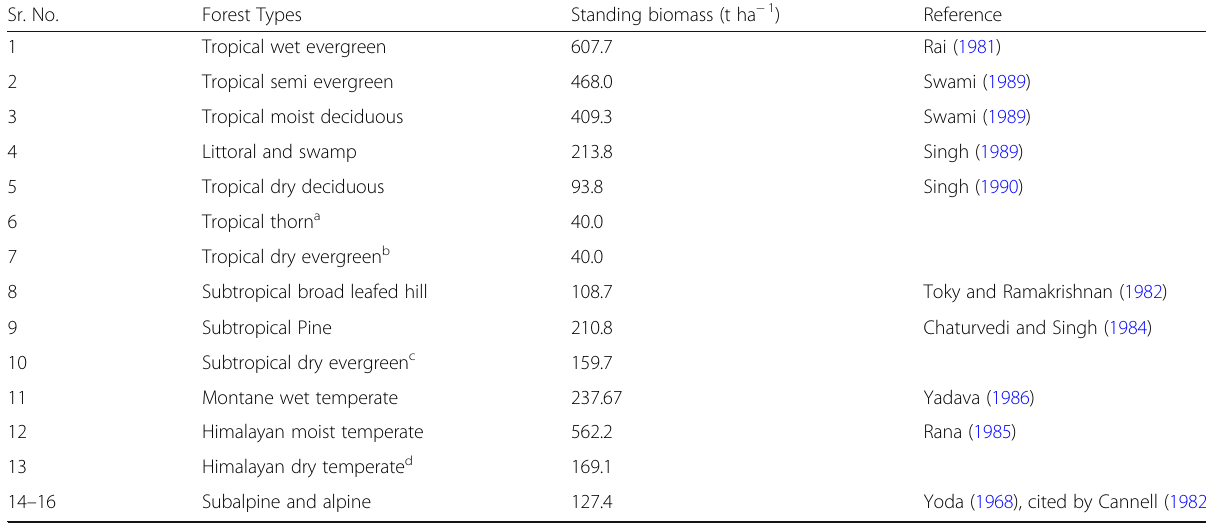
Table 6 Standing biomass of different forest types of India Sr.